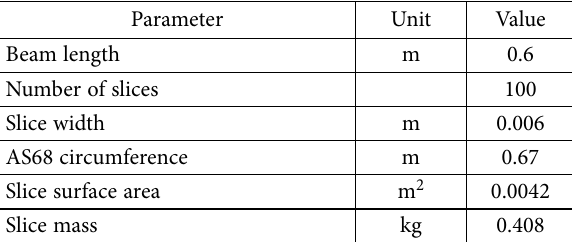
Table 9. Parameters for the beam model